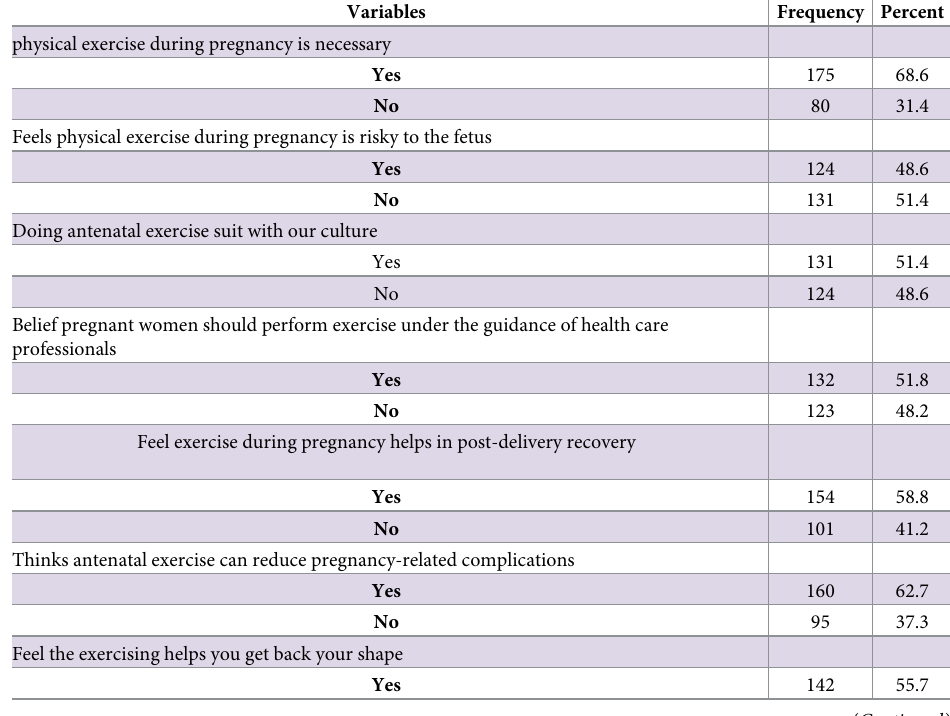
Table 3. Attitude towards antenatal exercise among pregnant women attending ANC in Mekelle health centers Tigray Ethiopia,